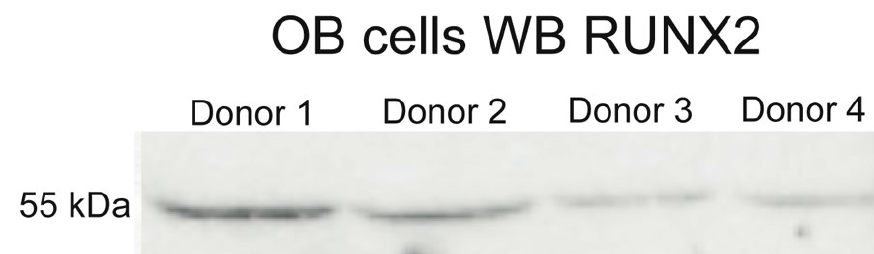
Figure 3. OB cells express RUNX2, marker protein of osteoblasts.